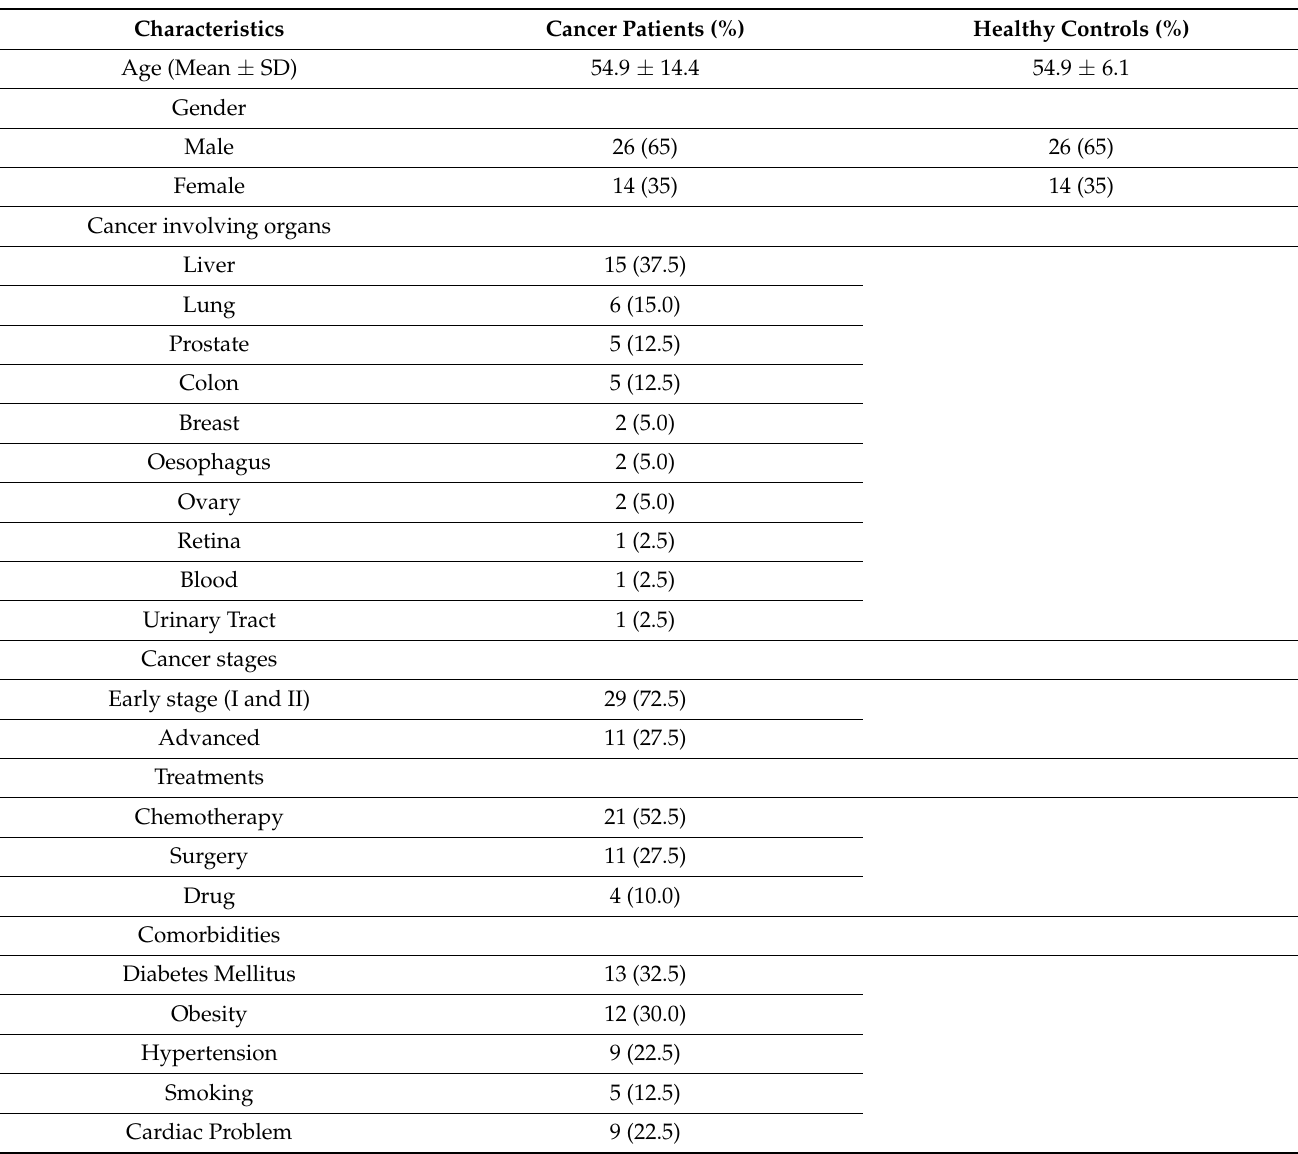
Table 1. Characteristics of the patients.